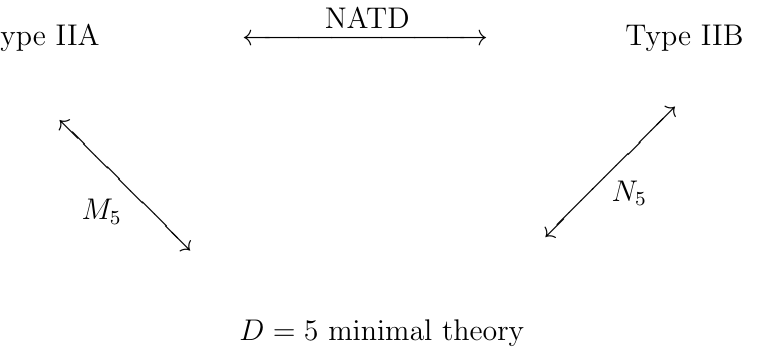
Figure 1 . A commuting diagram showing the different ways of obtaining/uplifting the minimal gauged supergravity in five dimensions from/to Type II